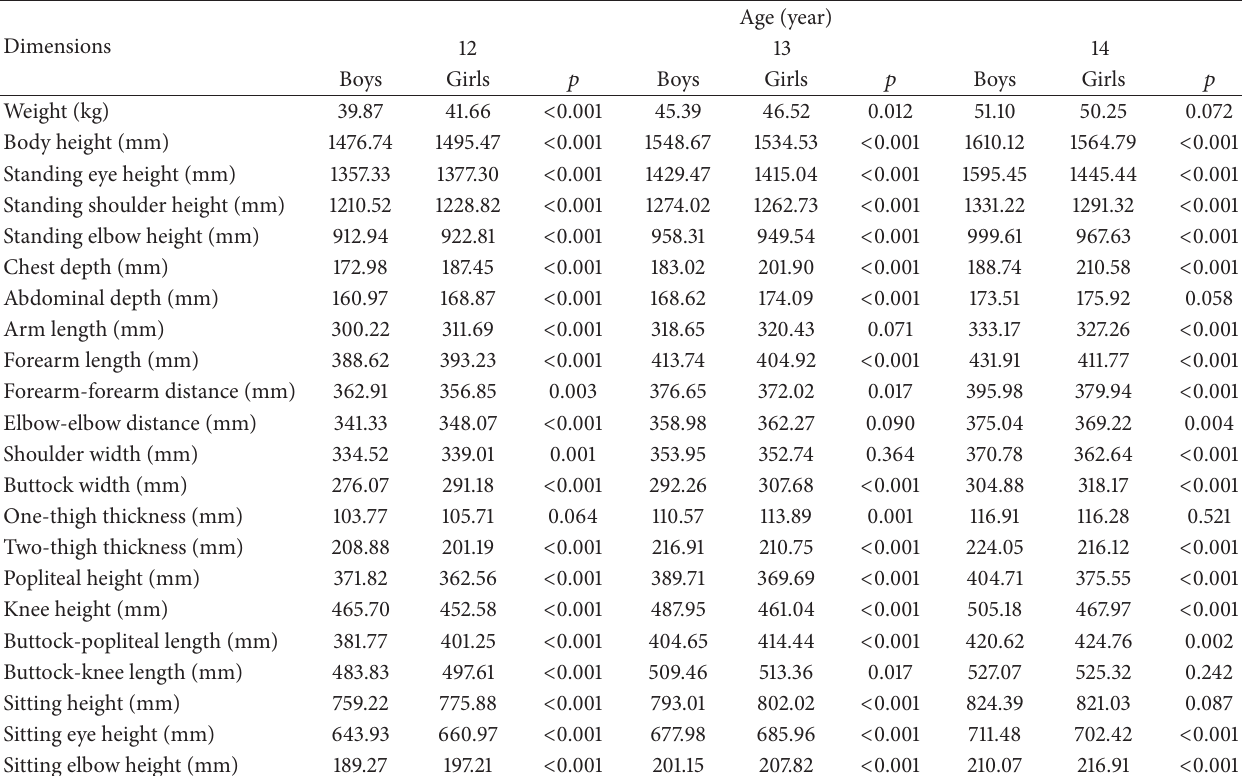
Table 5: Comparison of anthropometric dimensions between two